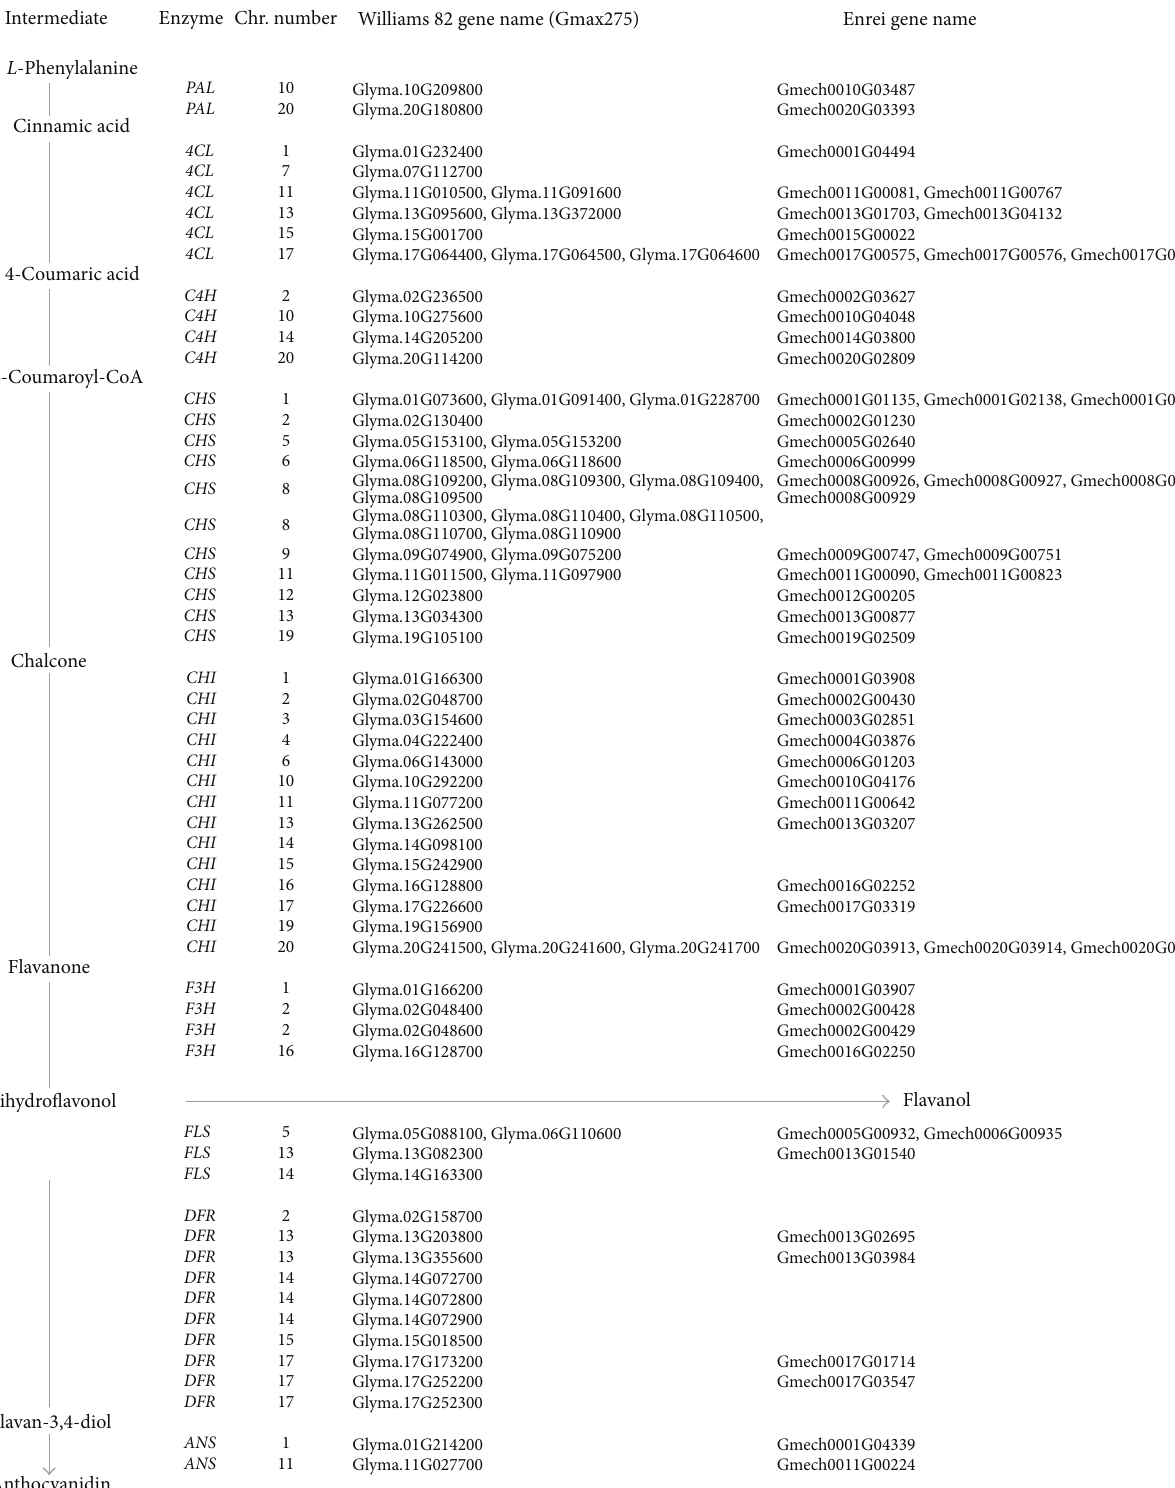
Figure 2: Enzymes involved in the major pathway for anthocyanin and flavonoid biosynthesis and the corresponding genes in Gmax275 and G. max cv. Enrei. PAL (phenylalanine ammonia-lyase), 4CL (4-coumaroyl-CoA-ligase), C4H (cinnamate-4-hydroxylase), CHS (chalcone synthase), CHI (chalcone isomerase), F3H (flavanone 3-hydroxylase), FLS (flavonol synthase), DFR (dihydroflavonol 4-reductase), and ANS (anthocyanidin